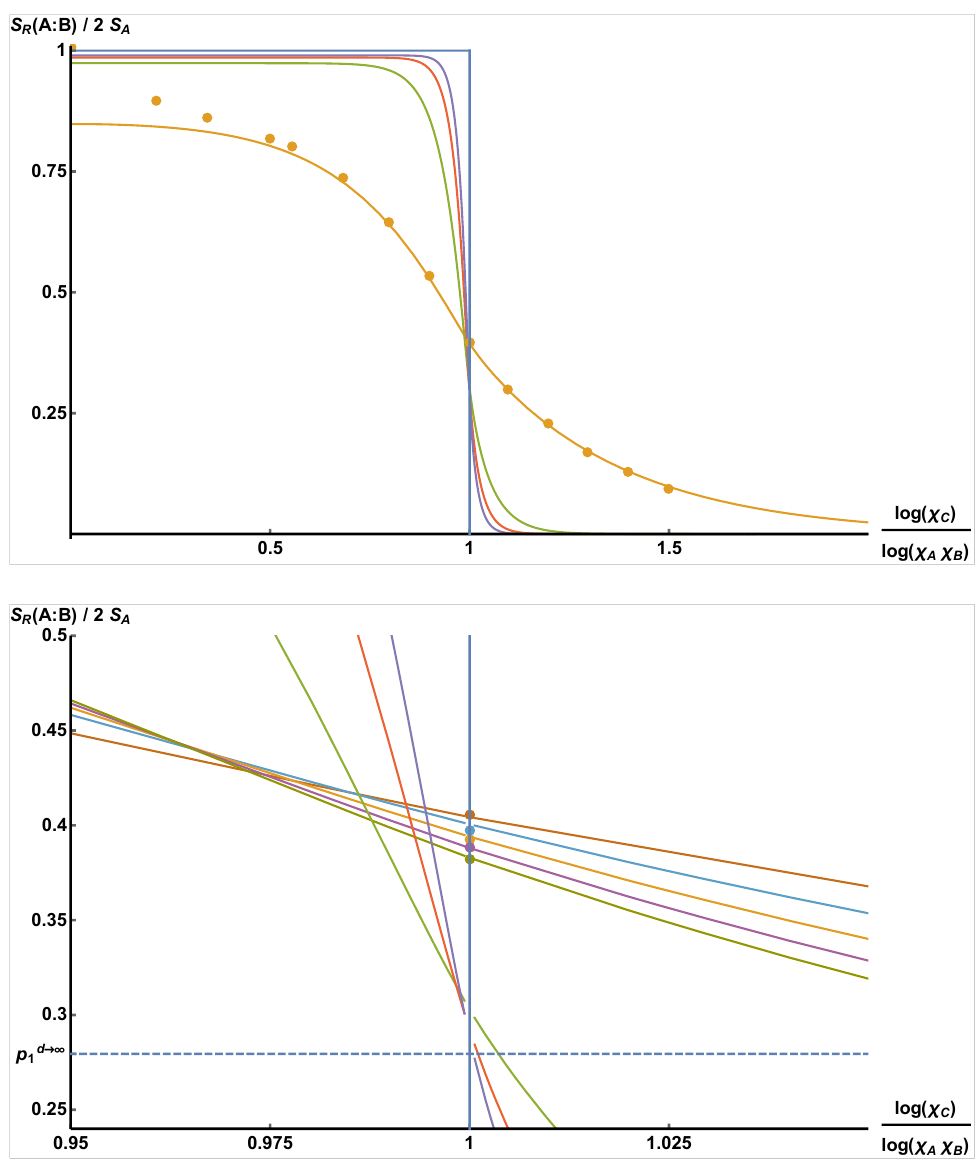
Figure 17 . Plots of the “Page curve” for reflected entropy. Our results capture the phase transition and agree with numerics. The disagreement in the top figure at small χ eq. (3.89) not being valid at small bond dimension. Note that the analytic functions plotted are not exactly eq. (3.89), but instead include a small correction, replacing p eq. (C.39), differing only at O (log( χ ) /χ 2 )